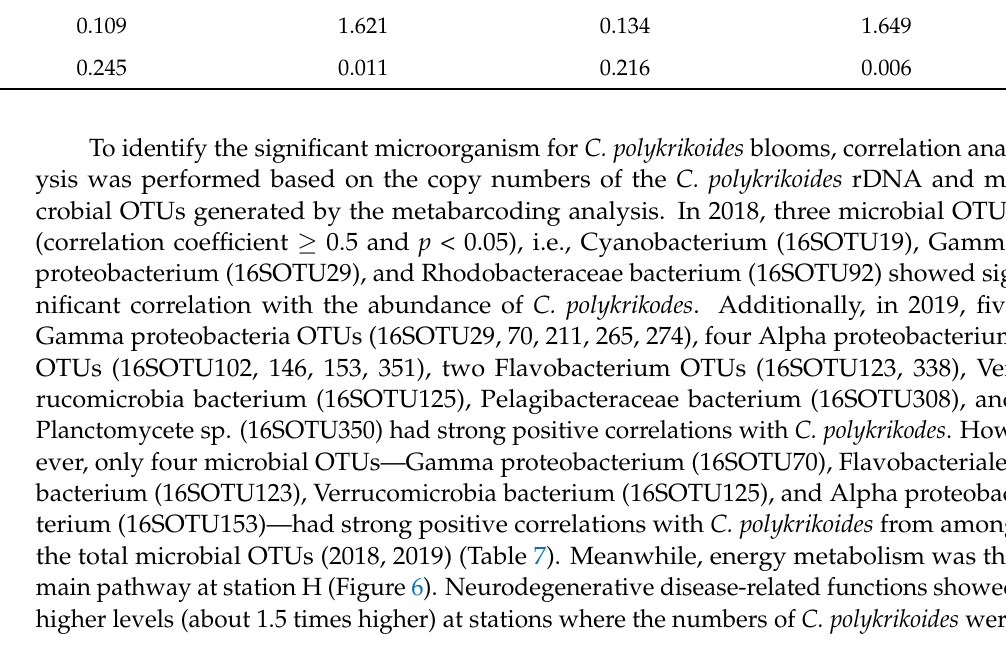
Figure 6. Microbial OTUs associated with C. polykrikoides are related to gene functional pathways. Gene functions were predicted from 16S rRNA gene-based microbial compositions using the PIC- RUSt algorithm to make inferences from KEGG pathways . Table 7. Microbial OTUs strongly correlated with C. polykrikoides . Year OTU Correlation Coefficient